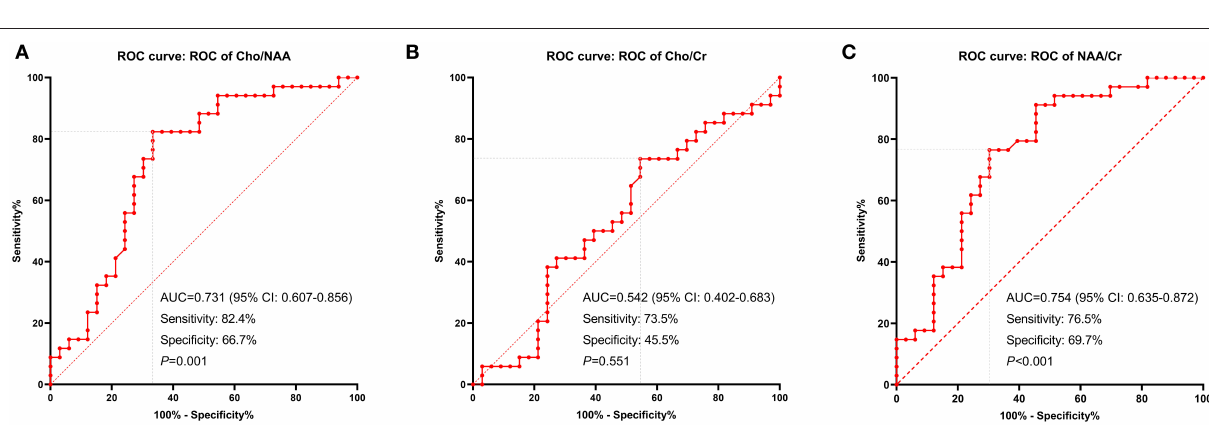
FIGURE 3 | ROC curves displaying the metabolic ratios: Cho/NAA (A) , Cho/Cr (B) , and NAA/Cr (C) in recurrence prediction. The cutoff ratio of Cho/NAA was 1.31 with an area under the curve (AUC) of 0.731 ( P = 0.001). The cutoff ratio of Cho/Cr was 1.43 with an AUC of 0.542 ( P = 0.551). The cutoff ratio of NAA/Cr was 1.10 with an AUC of 0.754 ( P <